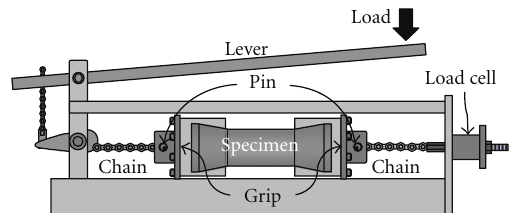
Figure 1: Direct tension test using a dog-bone-shaped specimen.